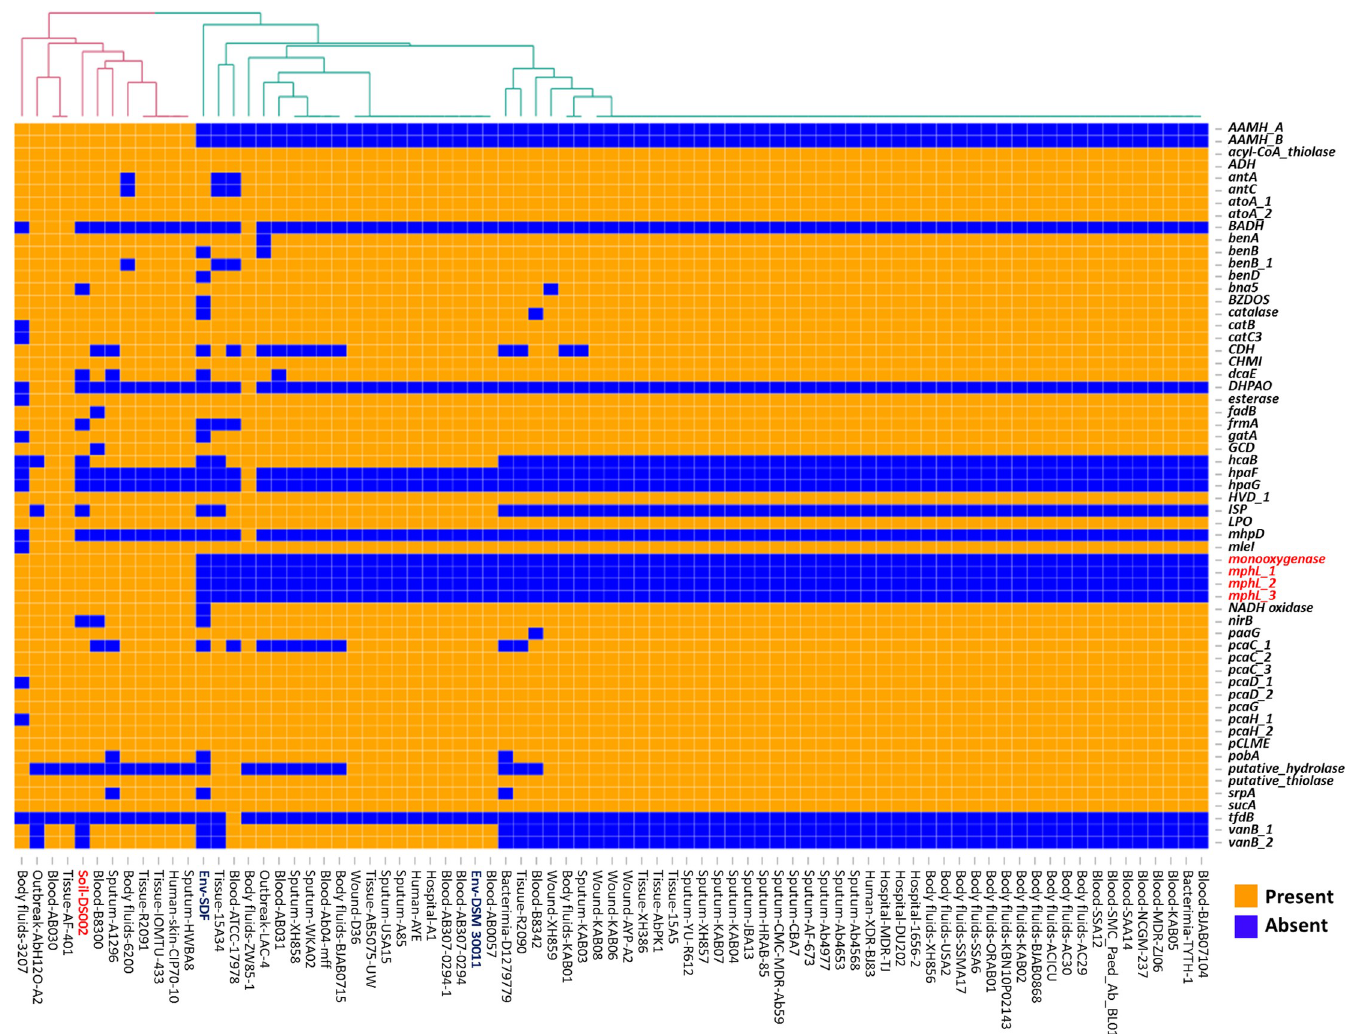
Fig 4. Heat map showing LS-BSR analysis of genes involved in carbon catabolism. Genes extensively discussed in the text as well as the strain DS002 are highlighted in red font.